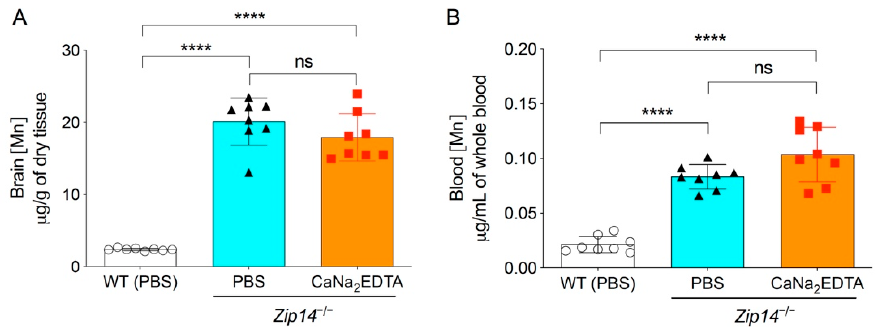
Figure 2. Metal chelation did not prevent the development of brain manganese overload. CaNa 2 EDTA was injected intraperitoneally into 1-week-old Zip14 − / − mice every other day for 2 weeks. Animals were sacrificed and tissues were collected when mice were 3 weeks old. Phosphate buffered saline (PBS) was used as the vehicle control. ( A ) Brain and ( B ) blood manganese concentrations were determined by ICP-MS analysis ( n = 8, 4 males and 4 females). Data were expressed as mean ± S.D. Statistical analysis was performed using one-way ANOVA, followed by the Bonferroni post-hoc test. **** indicates p < 0.0001; “ns” indicates not significant.